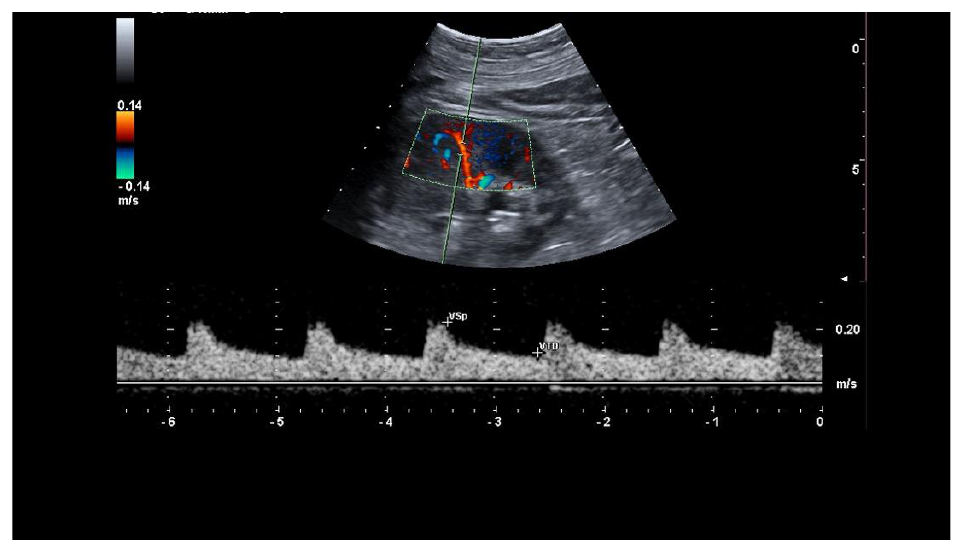
Figure 3. RRIs in a middle interlobular artery. The figure shows the exact sampling point of the Doppler signal at the level of the interlobar artery of the kidney for the representation of the Doppler spectrum on which the RRI is calculated. To note the regularity of the cardiac cycle (sinus rhythm) which allows to have an accurate measurement of the RRI and the sampling of the peak systolic and end diastole velocity in the same cardiac cycle.